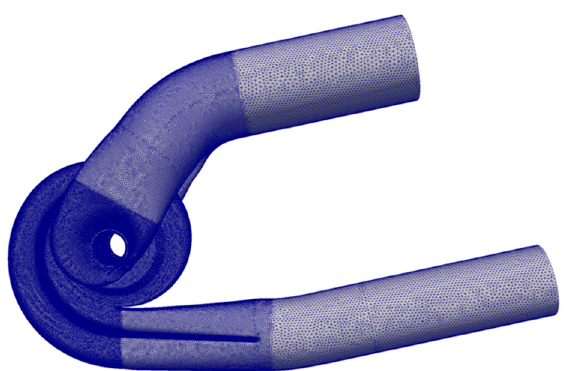
Figure 14. Front and side view of the CAD representing the centrifugal pump; the areas of Flange 1 and 2 were equal to 0.02840 m 2 and 0.01941 m 2 , respectively.